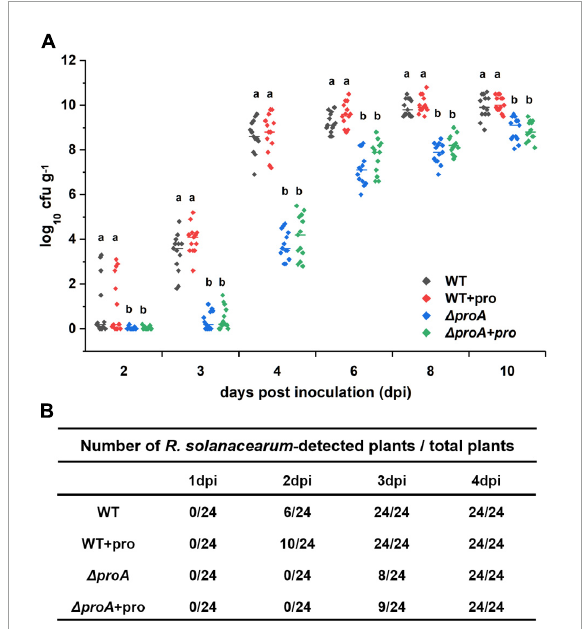
FIGURE5 Involvement of ProA in the invasion and colonization of R. solanacearum in tobacco xylem vessels. WT, the wild-type strain, RK5050 (OE1-1, popA-lacZYA ); (cid:49) proA , RQ5735 (RK5050, (cid:49) proA ); + pro, supplemented proline into pot soil. (A) Daily growth of R. solanacearum strains in tobacco xylem vessels; (B) percentage of plants colonized by R. solanacearum strains. For the proline supplementation, tobacco plants were irrigated with one-quarter of diluted Hoagland medium with supplementary proline at 10 mM for five times and subjected to bacterial inoculation. For the growth assay in tobacco xylem vessels, tobacco plants were inoculated with the inoculation method of soil-soaking, which mimics natural invasion through roots, and stem species were cut, weighted, and subjected to quantification of cell number by the dilution plating. Bacterial growth in xylem vessels was presented in log cfu g − 1 . Each assay was repeated with more than four biological replicates, including six plants per trial. Mean values of all experiments were averaged with SD, and statistical significance between the wild-type strains and mutants was assessed using a post–hoc Dunnett test following